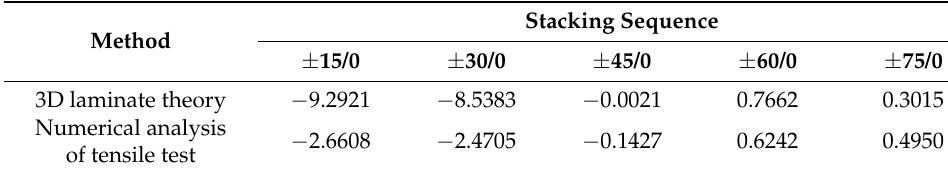
Table 12. The values obtained by Equation (25).